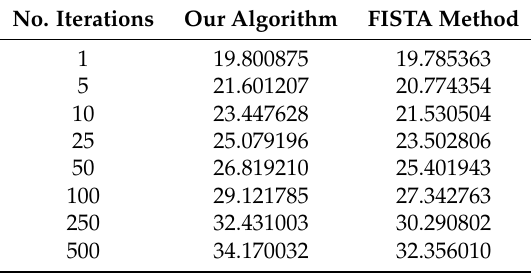
Table 3. The values of PSNR at x 1 , x 5 , x 10 , x 25 , x 50 , x 100 , x 250 , x 500 (Schonbrunn palace).